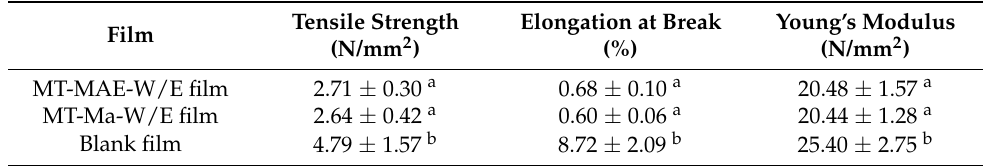
Table 4. Mechanical properties of prepared